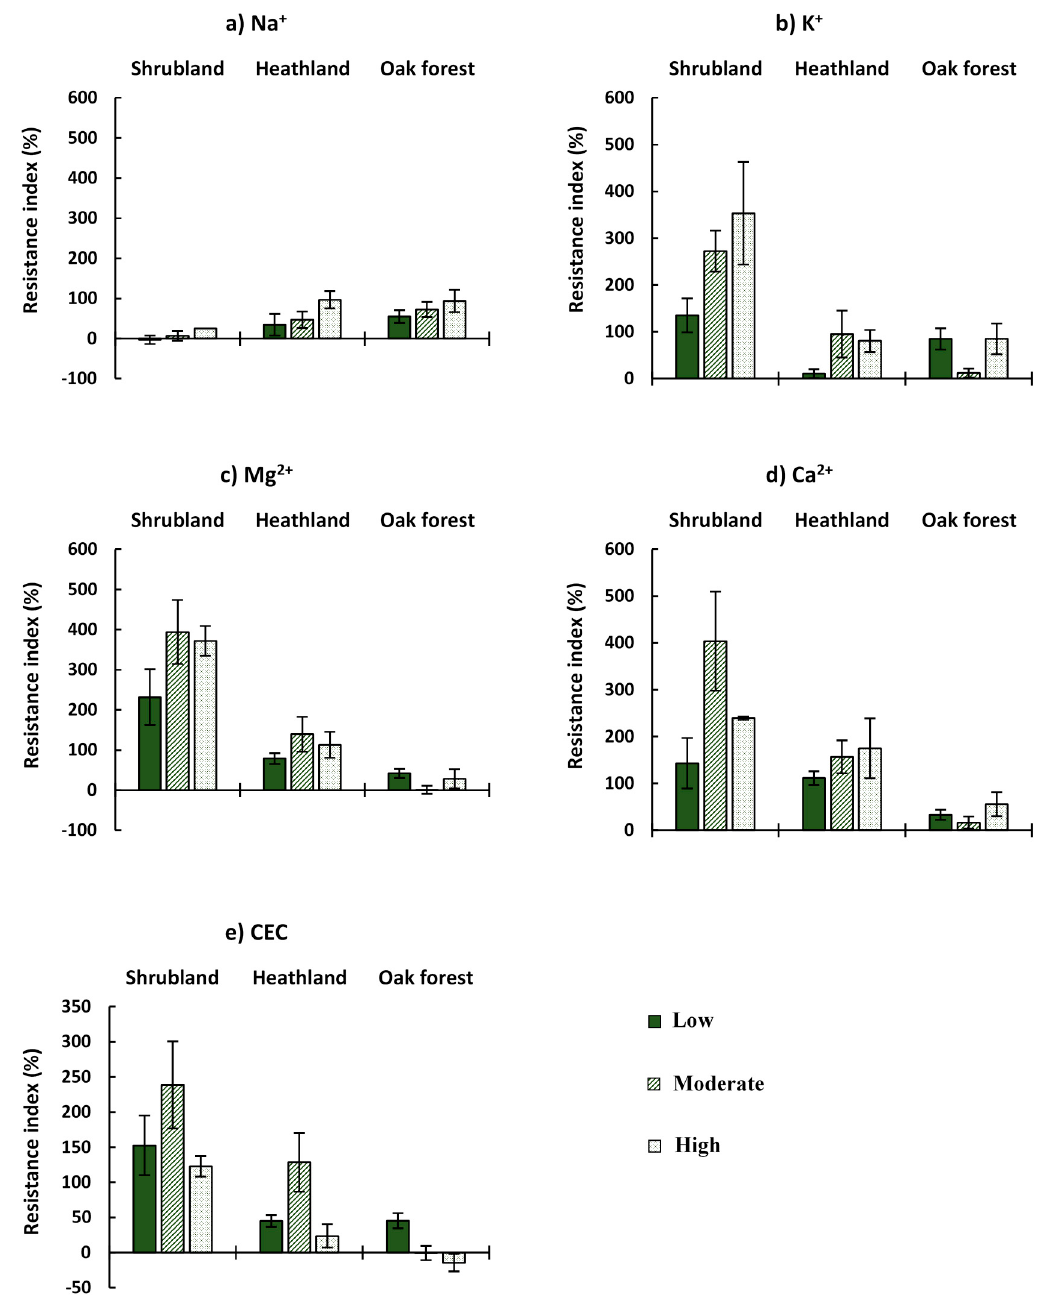
Figure 4. Average of ( a ) Na + , ( b ) K + , ( c ) Mg 2+ , ( d ) Ca 2+ , and ( e ) cation exchange capacity (CEC) resistance index values and standard error for each forestry ecosystem (shrubland, heathland, and oak forest) and burn severity level (low, moderate, and high) measured by the Composite Burn Index (CBI).